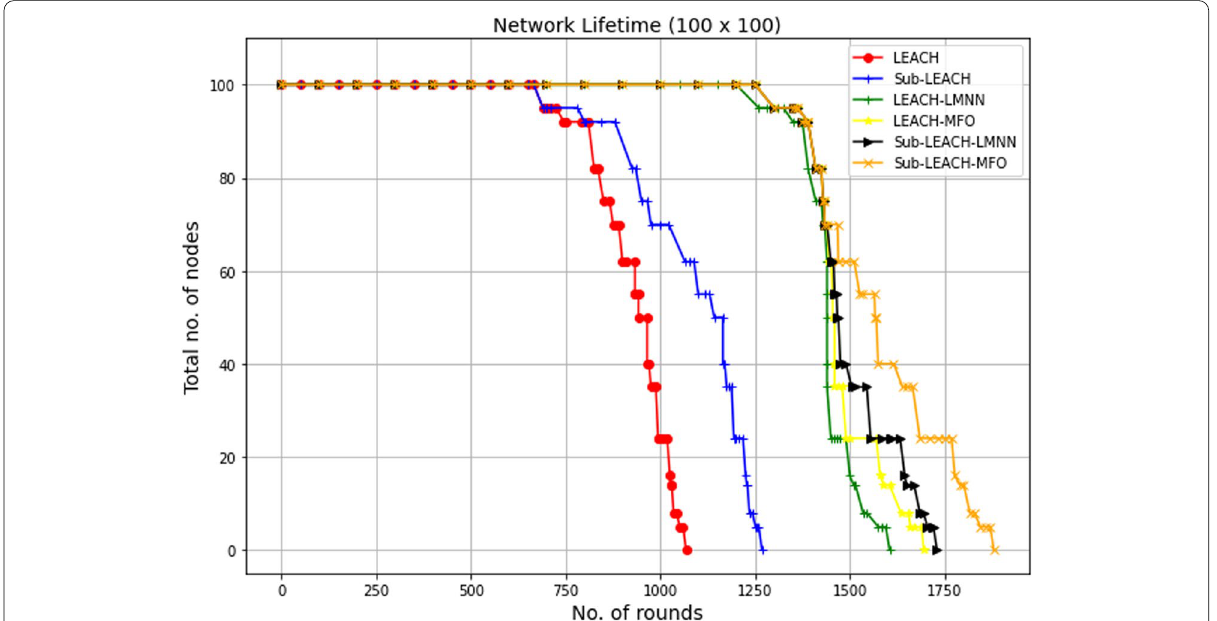
Fig. 9 Graphical representation of network lifetime for